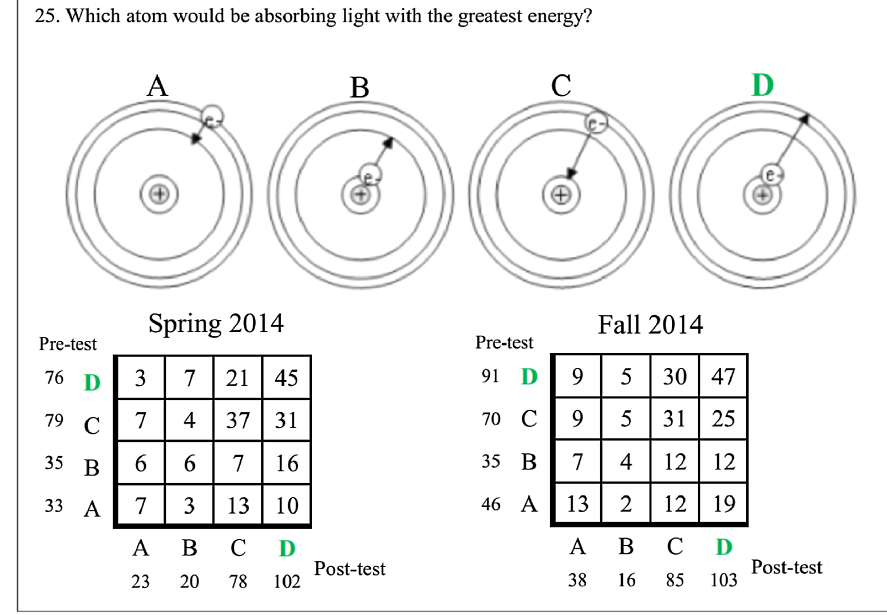
FIG. 6. Comparison of how students responded to TOAST question 25 on the pre- and post-test. Question adapted from Ref. [29].